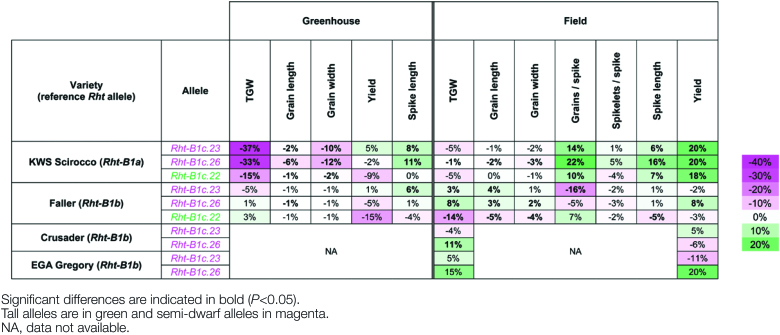
Effect of ovg alleles on grain size and yield in different wheat cultivars, in the greenhouse and fieldPercentage average difference of phenotypic traits for each ovg allele, relative to the reference allele, are shown. The scale next to the table details the intensity of color saturation for percentage difference. Greenhouse results were confirmed in at least two independent experiments. Representative data from the first experiment are shown.